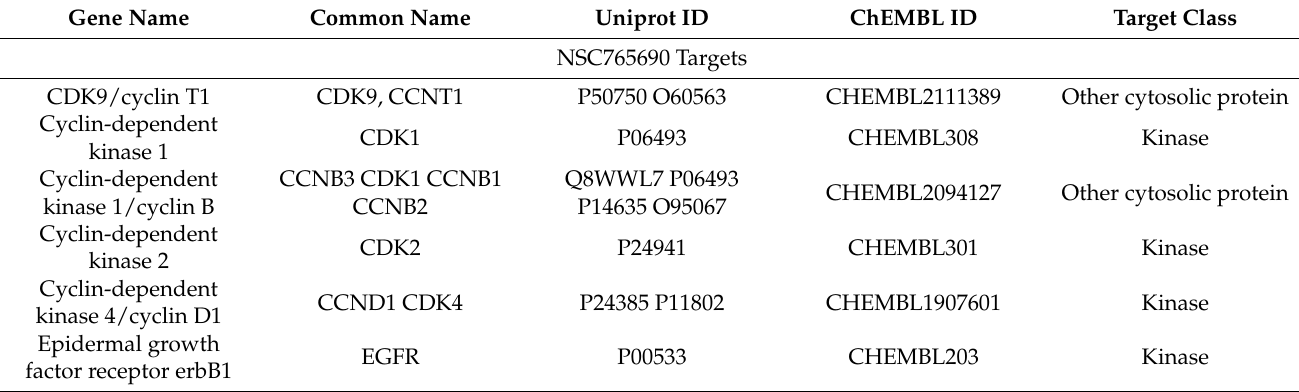
P: Pearson’s correlation coefficient. CCLC: Common cell lines count. Pearson’s correlation coefficient ranges from high − 1 (negative correlation) to +1 (high positive correlation). The higher the positive value, the more positive correlation between gene expression and NSC765599 and NSC765690 activities. Table 4. SwissTarget prediction of potential protein targets for NSC765690 and